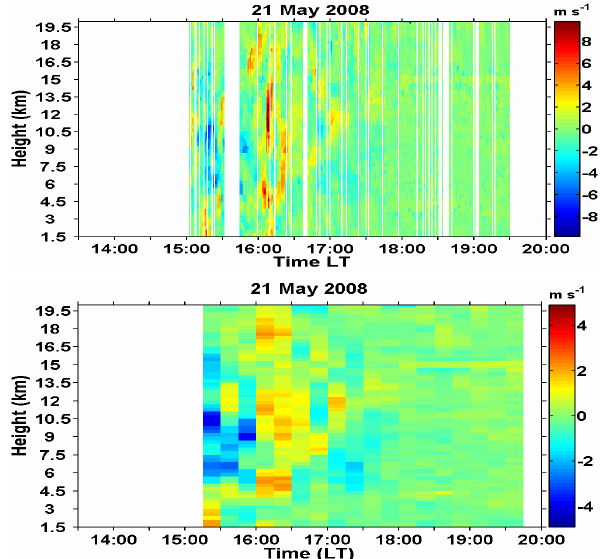
Fig. 5. Vertical velocity (ms − 1 ) derived from the MST radar data on 21 May 2008. The top panel shows wind speed averaged over a minute and the bottom panel shows the same averaged over